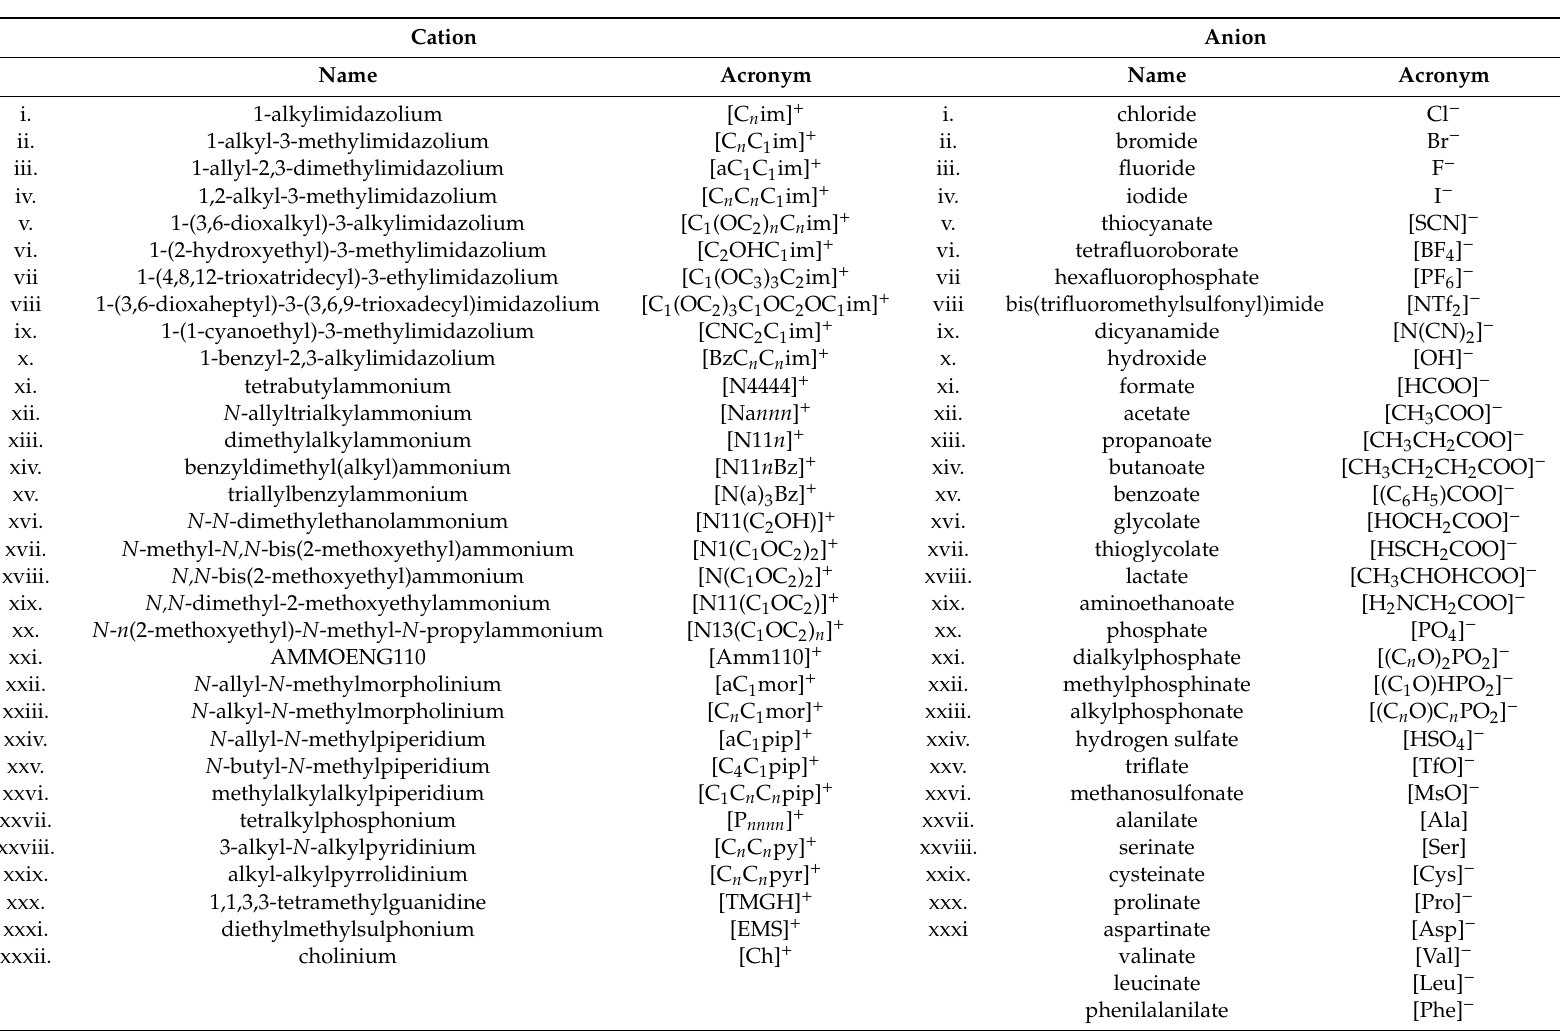
Table 2. Name and respective acronym of cation–anion combinations in ionic liquids